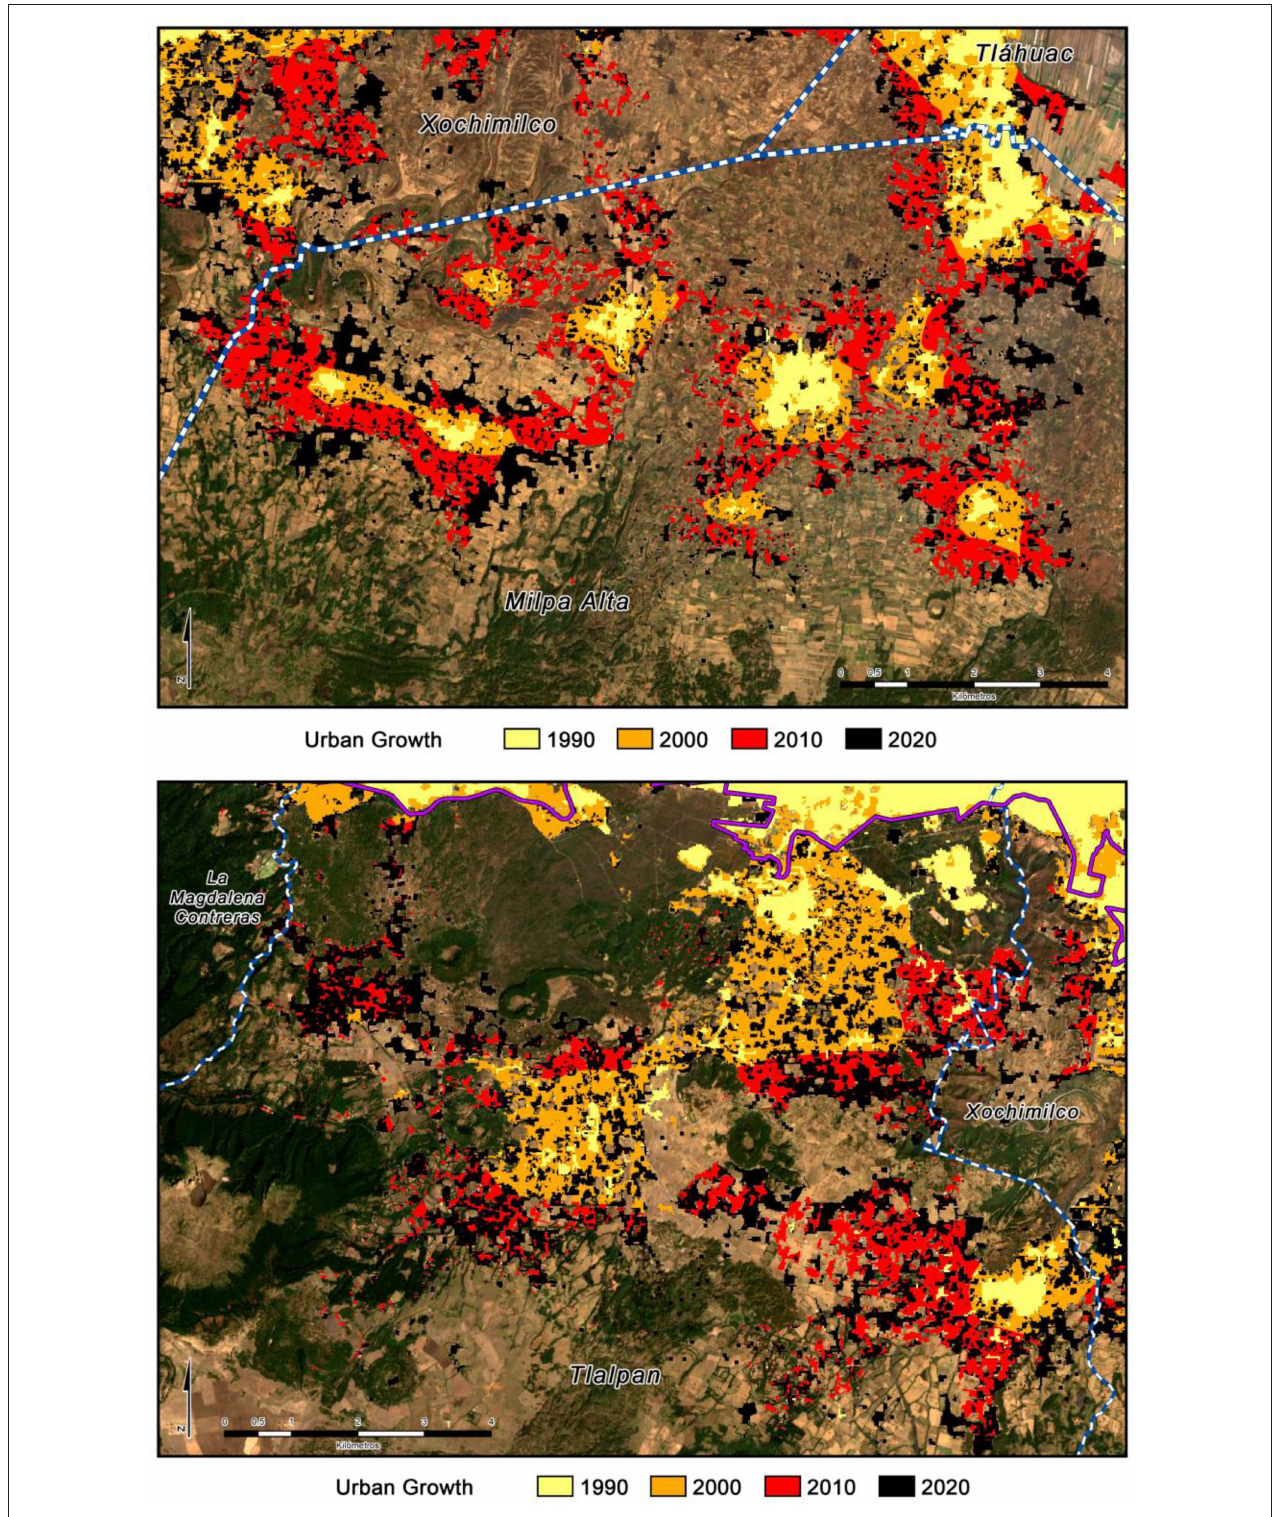
FIGURE 3 | The conservation zone: zoom of urban expansion in the Boroughs of Milpa Alta and Tlalpan, 1990–2020. Own elaboration from satellite images from sensors Landsat 4 TM; SPOT 4 and 5; and Rapid Eye.